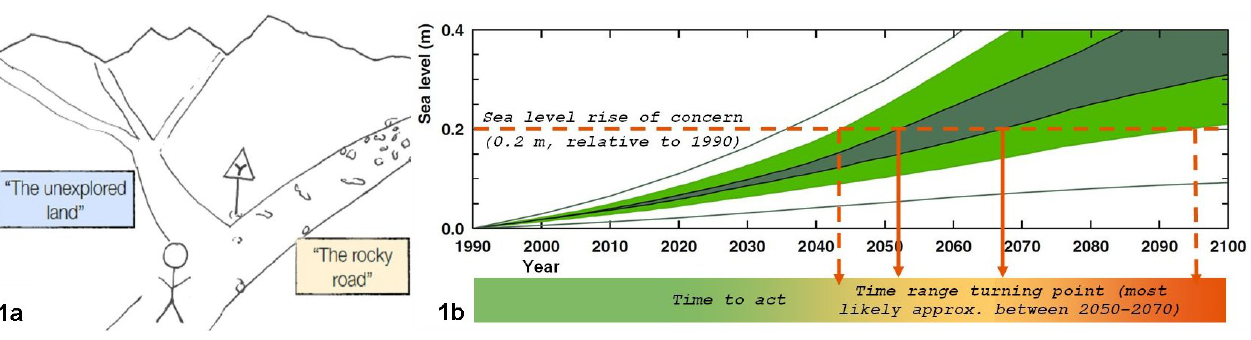
Fig. 1 . Illustration of an adaptation turning point. (1a) The current direction is becoming unattractive in time (the rocky road) and a turn to alternative routes may be considered (the unexplored land). (1b) A threshold (here: failing safety standards at a sea level rise of 0.2 m relative to 1990) is translated into a time range in which the threshold is likely to be reached. The figure uses projected global-averaged, sea-level rise for the 21st century from the Intergovernmental Panel on Climate Change (IPCC) assessment report (IPCC 2001). The dark shading is the model average envelope for all IPCC Special Report on Emissions Scenarios (SRES) greenhouse gas scenarios; the light shading is the envelope for all models and all SRES scenarios; and the outer lines include an allowance for an additional land-ice uncertainty (Church et al.